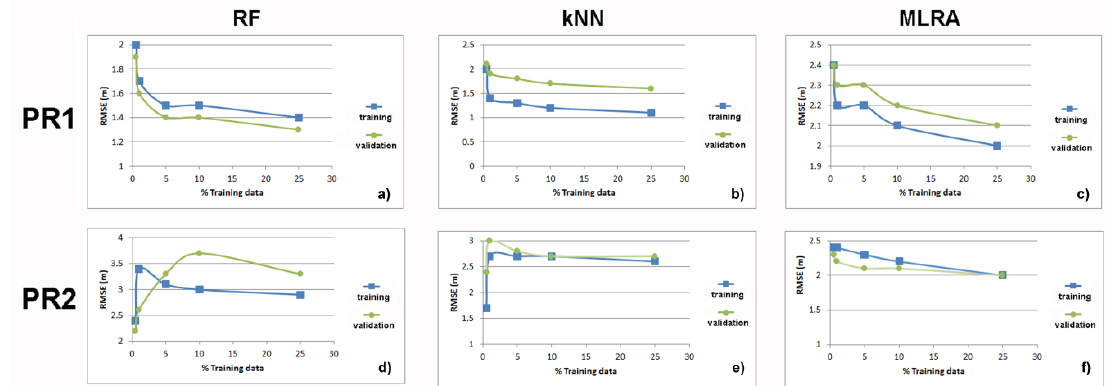
Figure A1. Learning curves of the algorithms used for predicting SDB in this study. Sub-area PR1: (a) Random forest, (b) kappa nearest neighbors, (c) multiple linear regression analysis. Sub-area PR2: (d) Random forest, (e) kappa nearest neighbors, (f) multiple linear regression analysis.